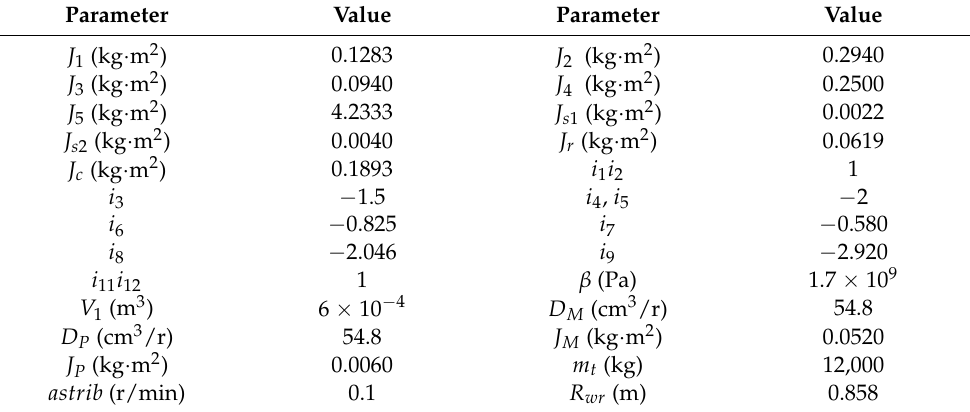
Table 2. Parameters used in simulation of the HMCVT mechanical system and the tractor.